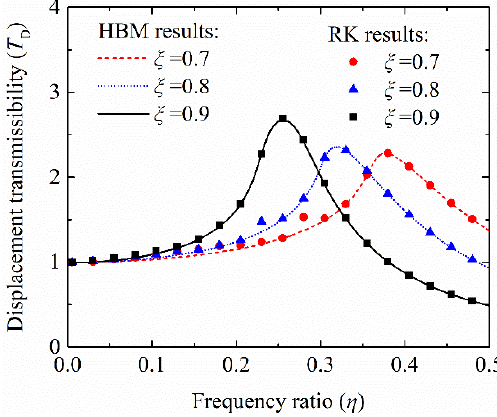
Figure 9. The frequency responses of the isolator with different values of ξ . Table 4. The lowest peak transmissibility/resonant frequency and the corresponding excitation amplitudes with different values of ξ . T pmin T pmin A b-pmin